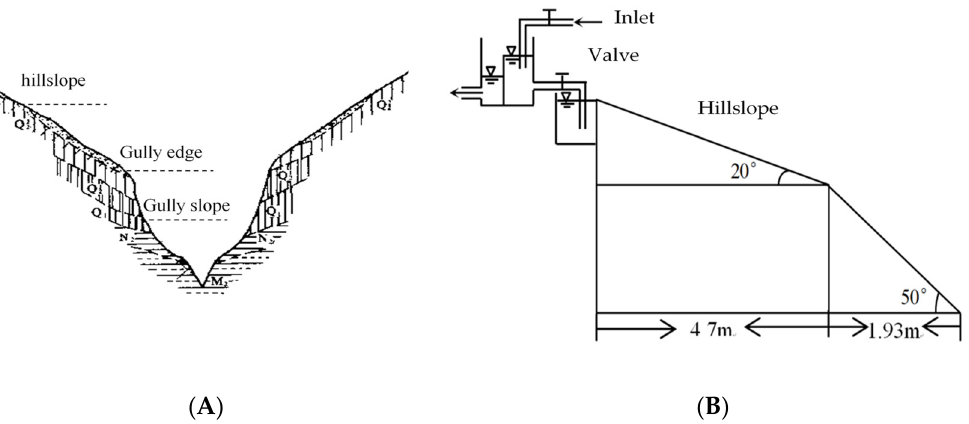
Figure 1. Schematic diagram of the hillslope ‐ gully system of the Loess Plateau ( A ) and the soil box designing diagram ( B ). designing diagram ( B